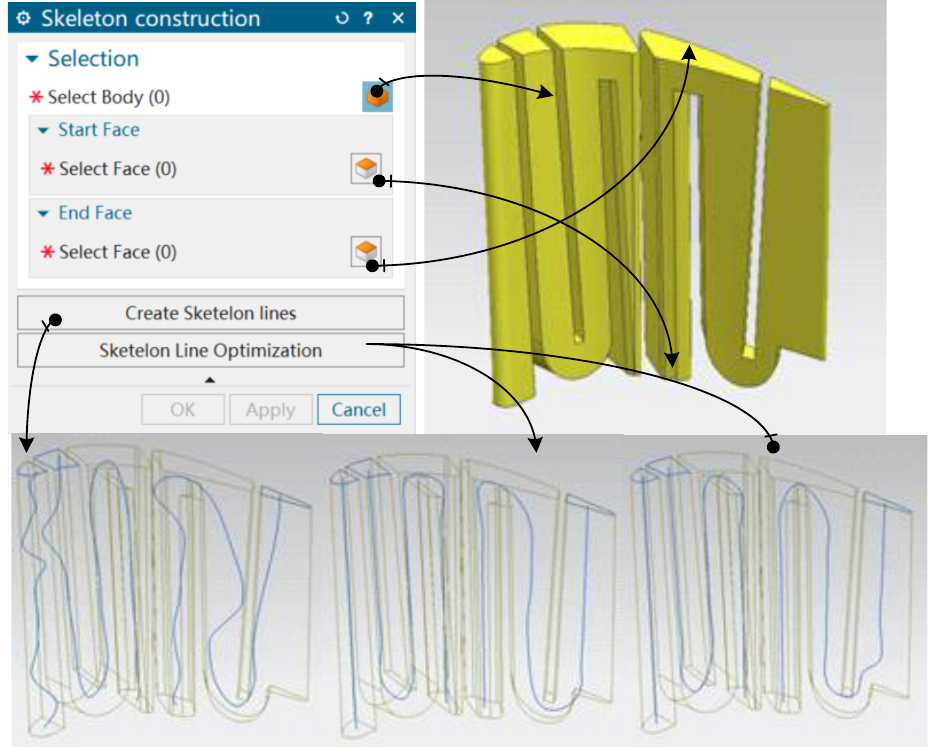
Figure 31. Interface of skeleton line of the flow